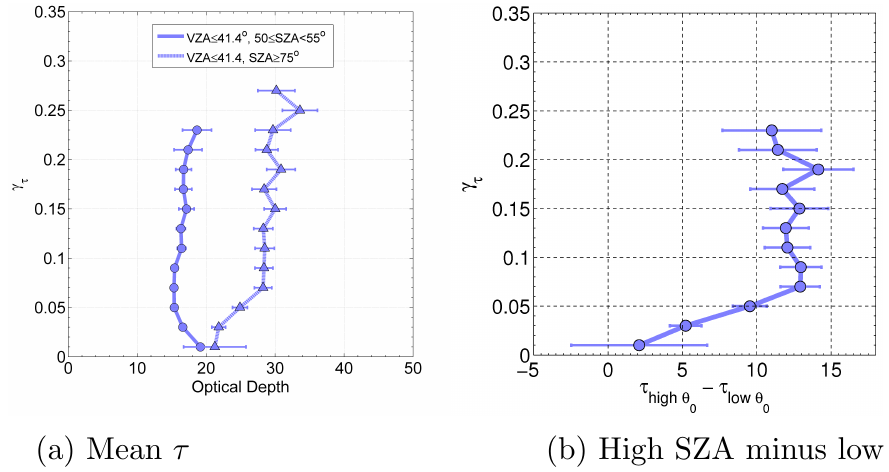
Figure 5: 2D histogram of two different heterogeneity parameters. Figure 12. As for Fig. 11 except for optical depth vs. γ τ , where γ τ is a measure of cloud heterogeneity based on the variability of the retrieved 1km cloud optical depth. Low values of γ τ indicate more